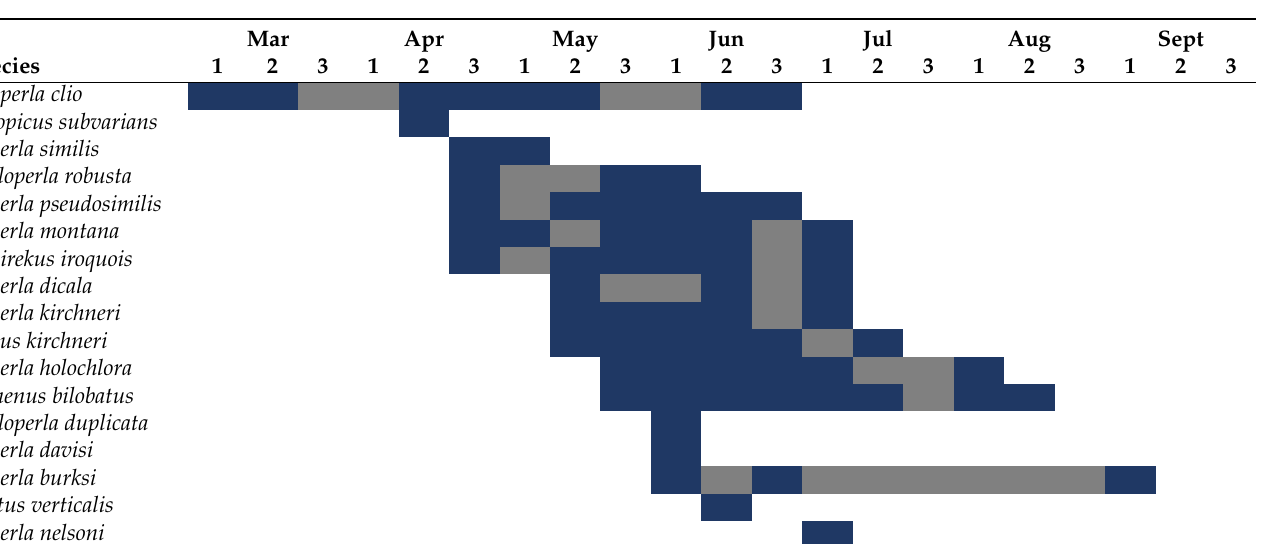
Figure 13. Elevation boxplots for Perlodidae species recorded from Maryland. Boxes represent the interquartile range, while vertical lines extend to the minimum and maximum values. The horizontal line within the interquartile range represents the median elevation. Outliers are shown with large, solid circles. Small, individual points overlaid on each boxplot illustrate the distribution of observations. Table 10. Recorded adult Perlodidae presence in Maryland. Months are broken into three 10-day periods. Dark blue squares represent periods with collections. Gray squares represent periods when species may be